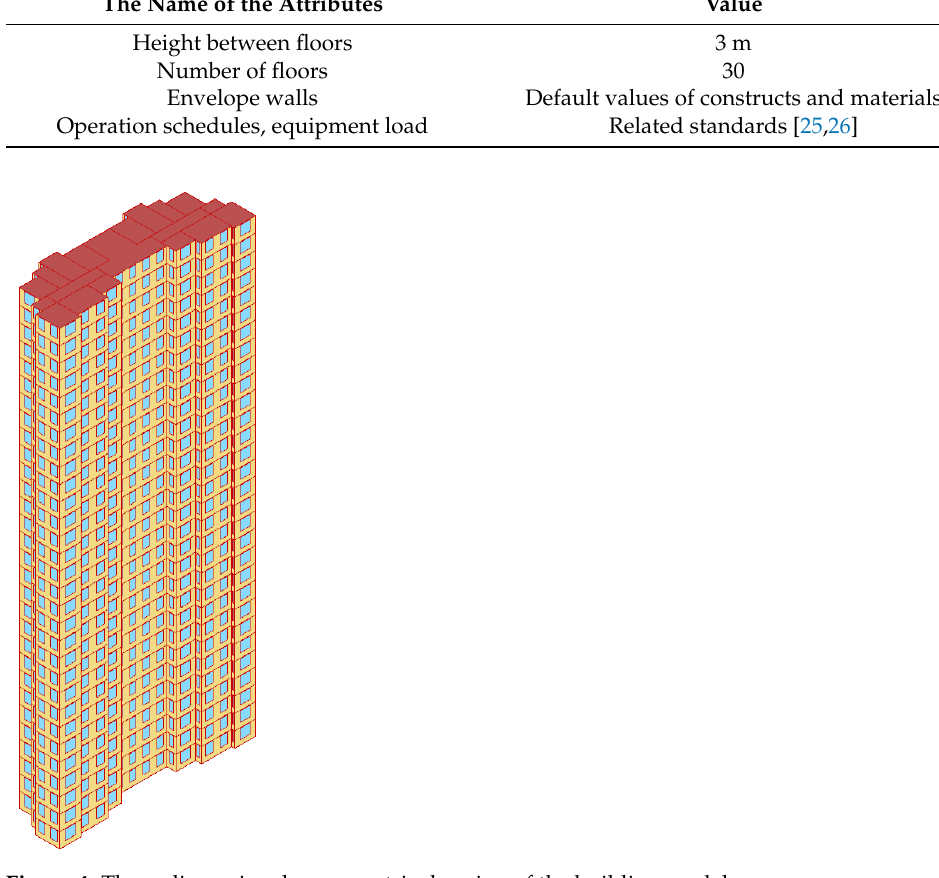
Figure 4. Three-dimensional axonometric drawing of the building model.